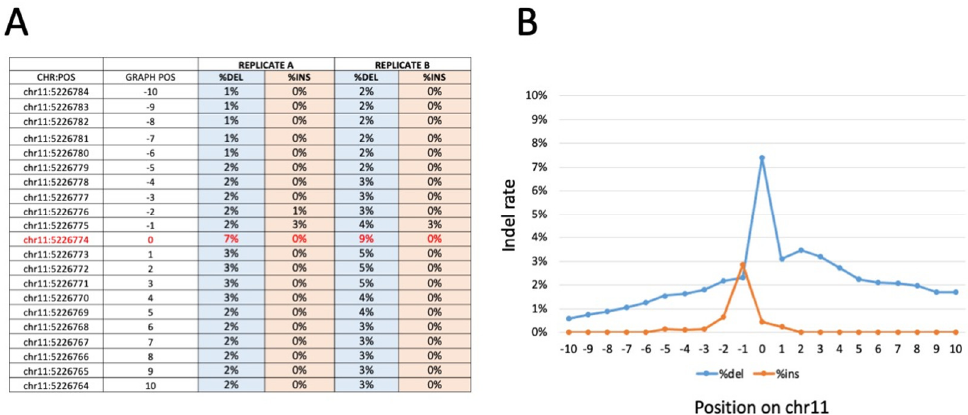
Figure 5. Representative indel frequency and positioning around the β 0 39 CRISPR-Cas9 editing target site, obtained with amplicon sequencing of β 0 39 ErPCs treated with the CRISPR-Cas9 system. Panel ( A ) shows the indel frequency values for the amplicon replicates analyzed. In particular, the ten positions upstream and downstream from position chr11: 5226.774 ( β 0 39 target site indicated in red) were analyzed. The data obtained are reported in panel ( B ) in which the percentage of deletion (blue line) and insertion (orange line) is graphically reported as a function of each nucleotide position investigated. Similar results were obtained with WGS sequencing (Figure S7).